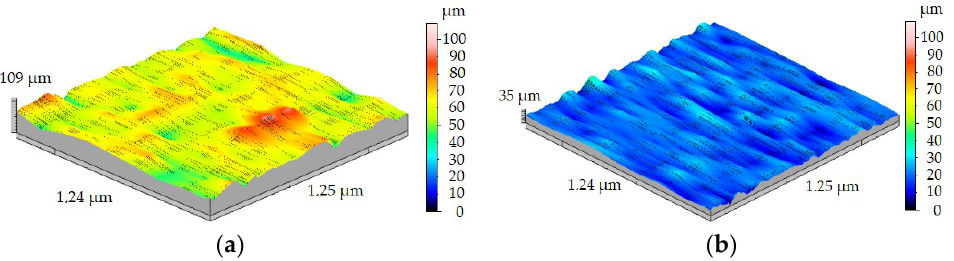
Figure 12. Results of 3D surface measurement samples before turning of: ( a ) FEPA 046, ( b ) FEPA 100.